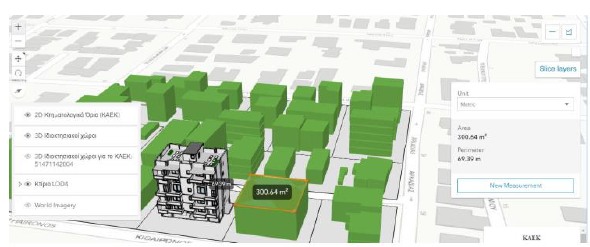
Figure 6. User’s interface of BIM-GIS Platform after the measurement tool being executed.